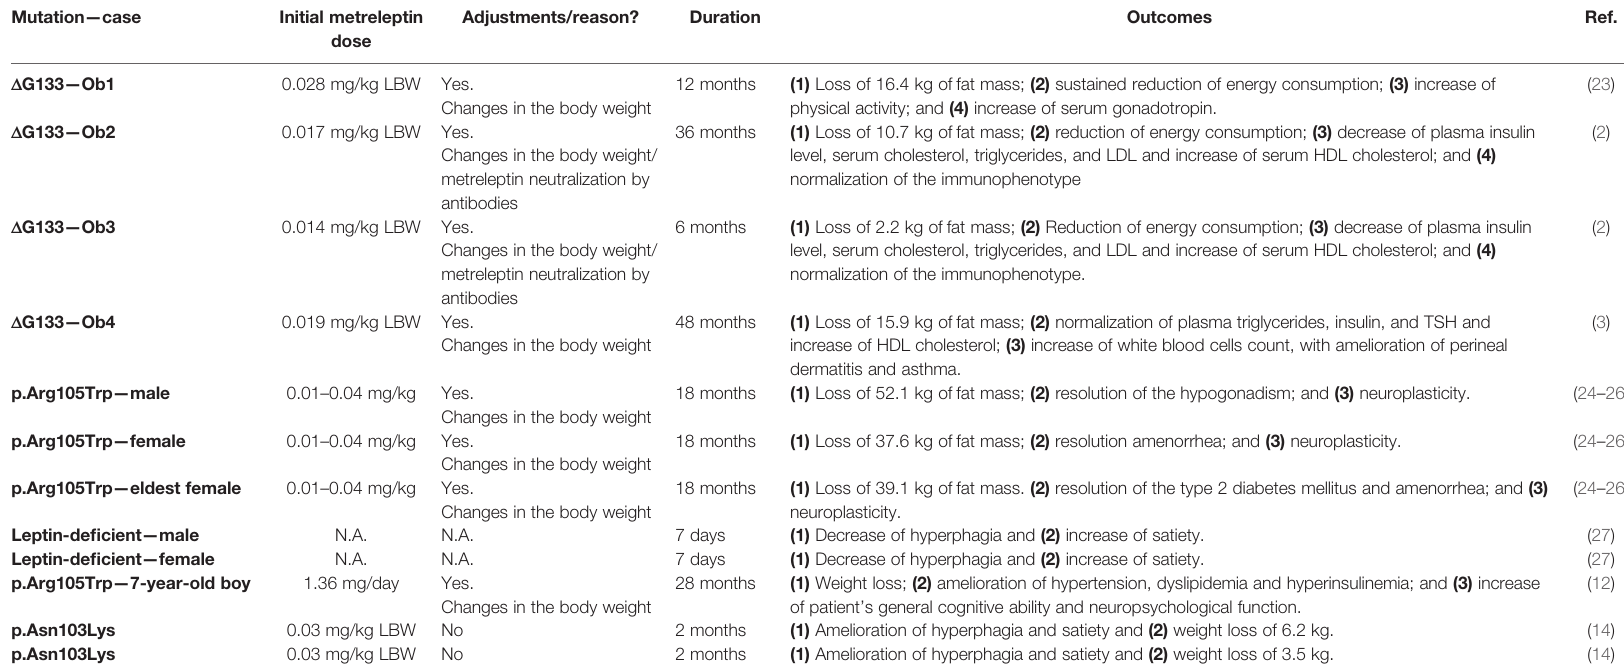
TABLE 3 | Bene fi ts of the metreleptin